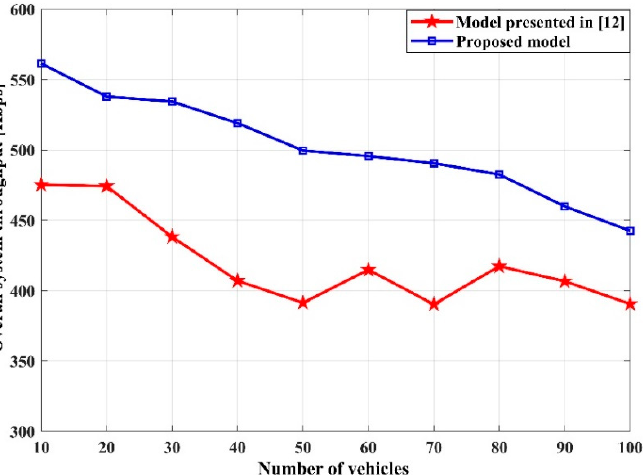
Figure 13. System throughput (S) vs. number of vehicles at variable vehicles’ velocity.